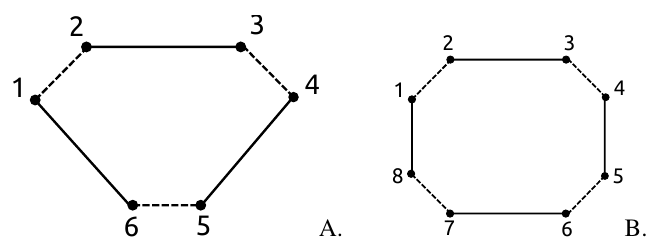
Figure 2: A : Amputated irreducible planar 3-point vertex. B : Amputated irreducible planar 4-point vertex Figure 1: 3-point and 4-point contact vertices.